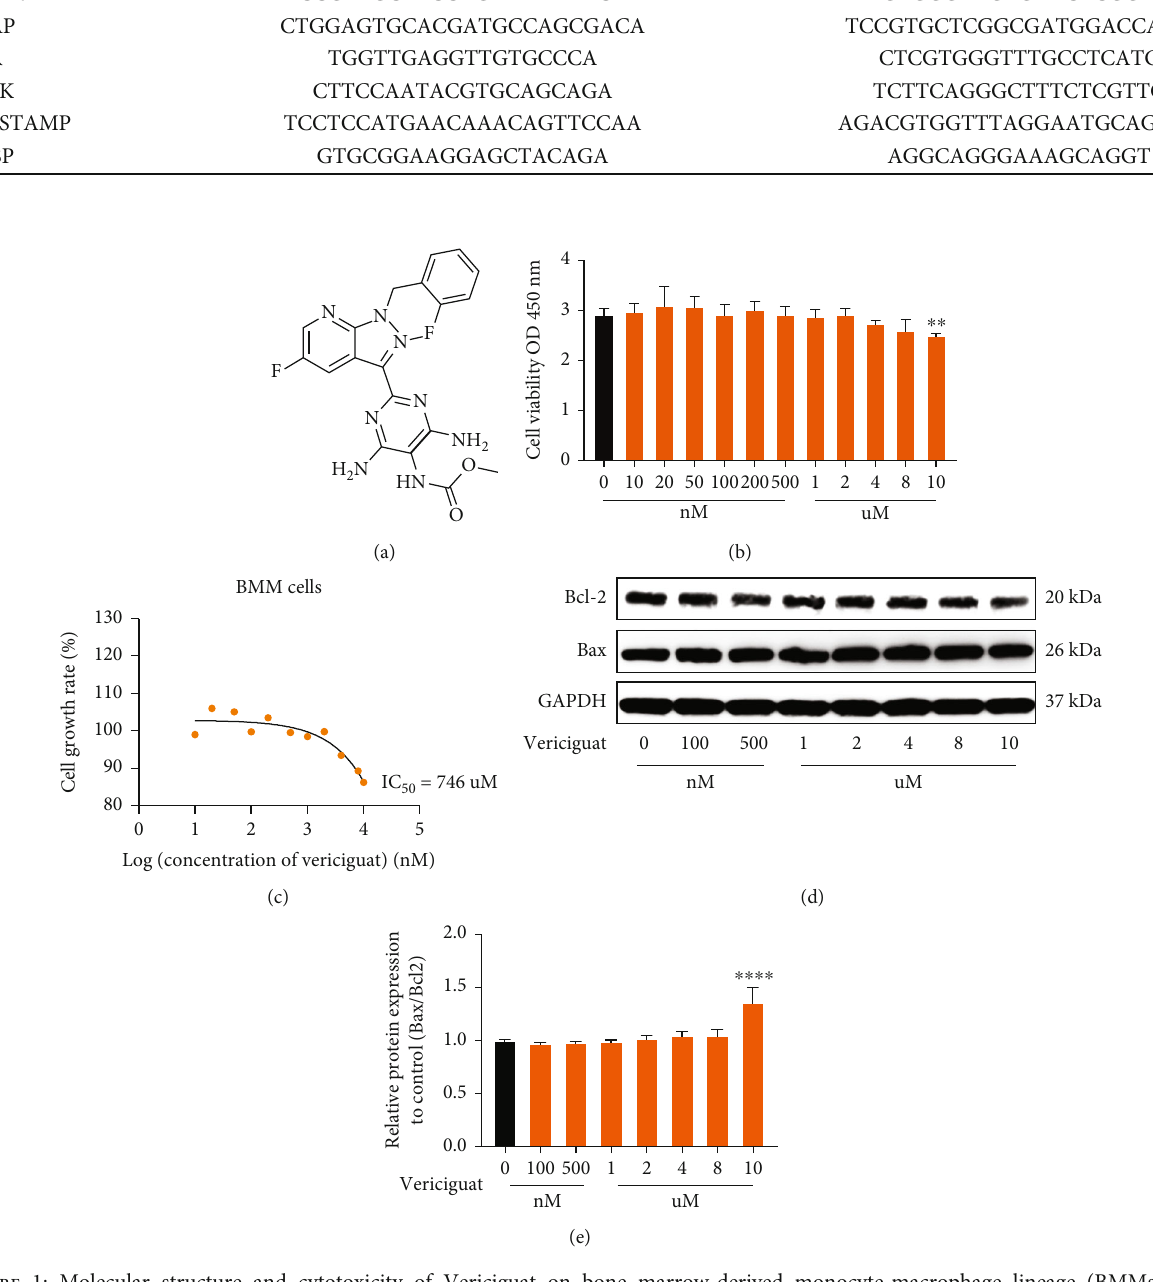
Figure 1: Molecular structure and cytotoxicity of Vericiguat on bone marrow-derived monocyte-macrophage lineage (BMMs). (a) Molecular structure of Vericiguat; (b) BMM cell viability as detected by CCK-8 assay after treatment with indicated concentrations of Vericiguat for 24 h. Data are presented as mean ± standard deviation ( n = 5 ). (c) The IC values of Vericiguat against BMMs. (d, e) The 50 e ff ect of Vericiguat on apoptosis-related markers, Bax and Bcl-2, in BMMs and quantitative results ( n = 3 ). ∗ indicated a comparison with the control group (0 nM): ∗ p < 0 : 05 , ∗∗ p < 0 : 01 , ∗∗∗ p < 0 : 001 , and ∗∗∗∗ p < 0 : 0001